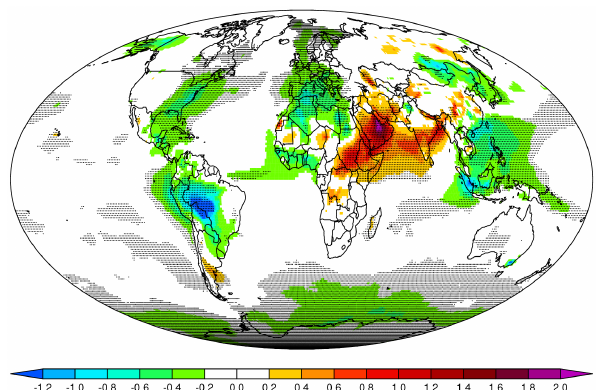
Figure 13. Trends of the deseasonalized reanalysis total AOT at 550nm over 2003–2013 (unit: 100 × AOTyear − 1 ). The dotted ar- eas have passed the 95% statistical significance level (see text and Zhang and Reid, 2010, for